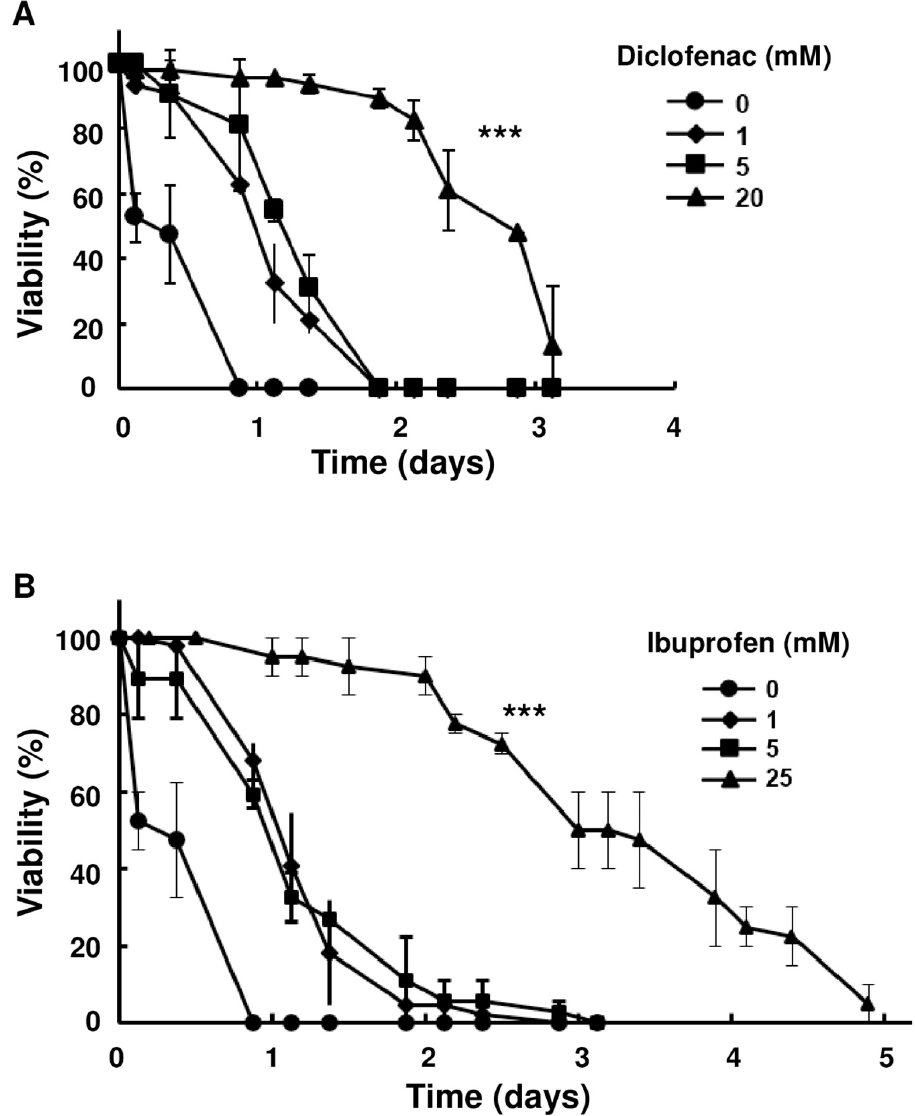
Fig 4. Effect of NSAIDs (diclofenac and ibuprofen) on the viability of md-TRPV1(3) flies grown on capsaicin (5 mM)-containing food at 29˚C. Drugs were added to food at the concentrations indicated in the figure. Dots and vertical lines denote means and standard deviations, respectively. n = 60 for each curve; one-way ANOVA with the Tukey-Kramer method for multiple comparisons, ��� P < 0.001 for no diclofenac vs 20 mM diclofenac and for no ibuprofen vs 25 mM ibuprofen. All flies were 5-day-old males. md-TRPV1(3) denotes one copy of md-Gal4 and 3 copies of UAS-TRPV1 .